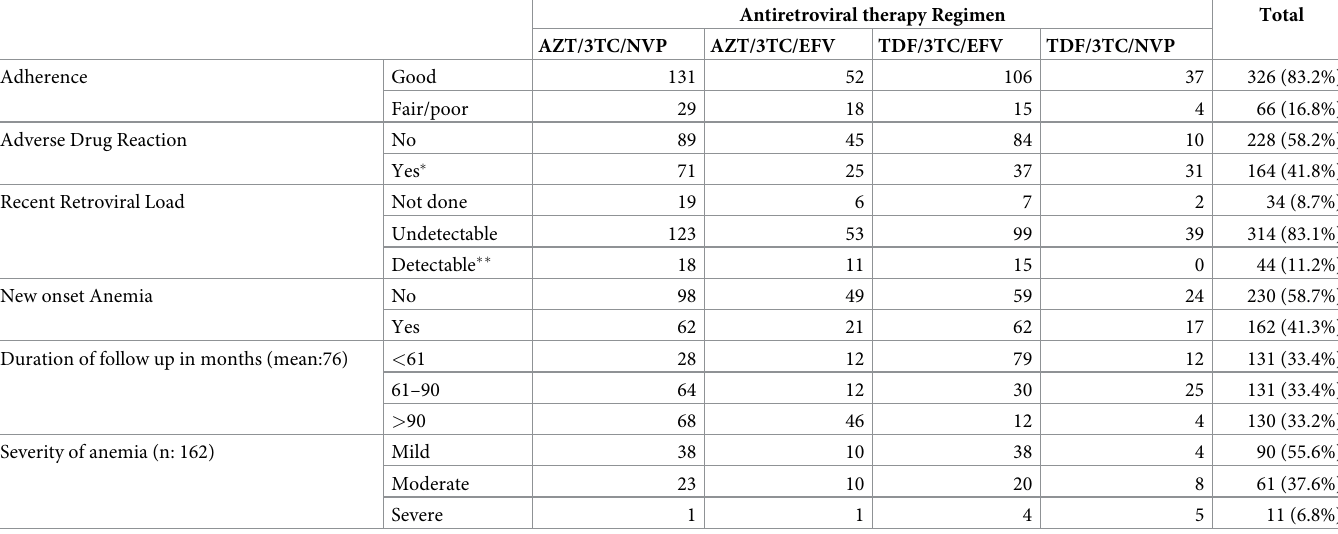
Table 2. Interim treatment outcome among adults on HAART in Northeast Ethiopia: